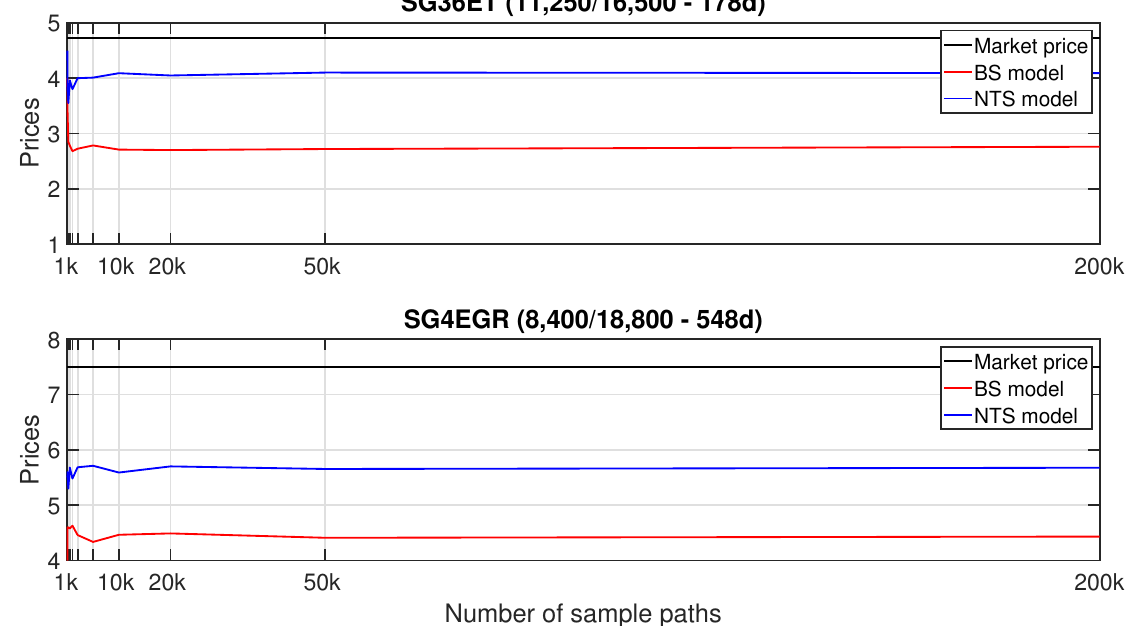
Figure 8. Visualisation of noise in our chosen Monte-Carlo pricing scheme for two barrier options with different barriers (11,250/16,500 vs. 8400/18,800) and time to maturity (178 days vs. 548 days) for various numbers M of sample paths. Even though for maturities farther in the future, the NTS model still seems to miss market prices, its supremacy on the Gaussian setup is evident. Additionally, this miss does not necessarily present model issues as it could also be interpreted as evidence that issuer margins are especially high for such long product